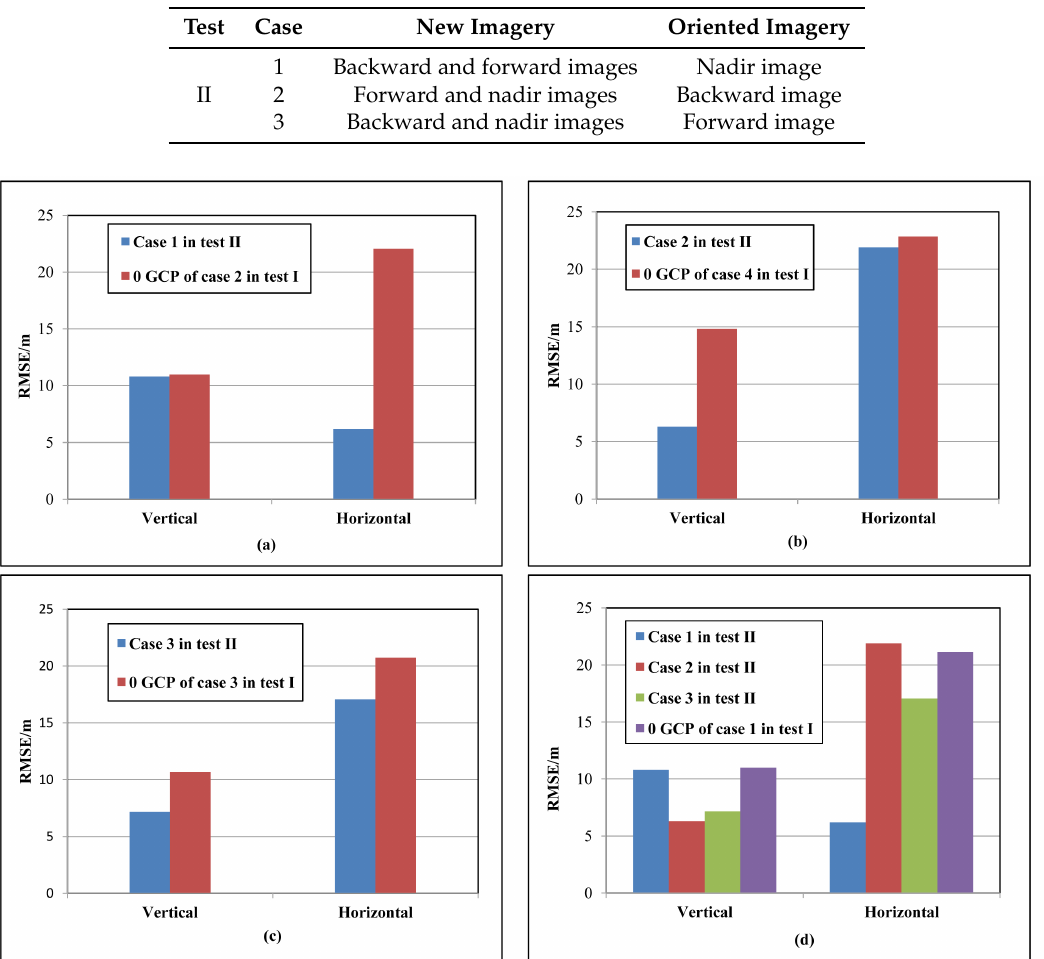
Figure 9. Accuracy Comparison between Case 2 of Test II and Test I with ZY-3 images: ( a ) accuracy comparison of Case 1 in Test II with Case 2 in Test I without GCPs; ( b ) accuracy comparison of Case 2 in Test II with Case 4 in Test I without GCPs; ( c ) accuracy comparison of Case 3 in Test II with Case 3